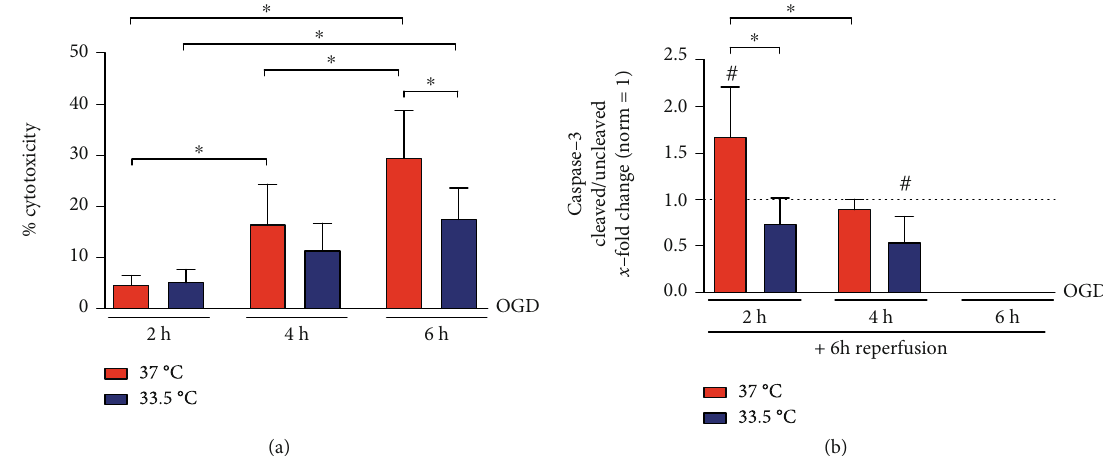
Figure 2: Increasing duration of OGD exposure resulted in a transition from apoptotic to necrotic cell death in the murine primary cardiomyocytes that could be attenuated by TTM. (a) OGD-induced toxicity as measured by LDH release at 2, 4, and 6 hours is presented as % cytotoxicity relative to positive (100%) and normoxia (0%) controls. (b) Apoptotic programmed cell death was assessed by cleavage of caspase-3 after exposure to 2, 4, or 6 hours OGD followed by 6 hours of reperfusion and is presented as x -fold change relative to normoxia control at the respective experimental time points. Data from at least 3 independent experiments are shown as mean ± SD , and statistical analysis was performed using one-way ANOVA with Tukey posttest; # p < 0 : 05 as compared to 37 ° C normoxia control group and ∗ p < 0 : 05 for comparisons between the two experimental groups were considered signi fi